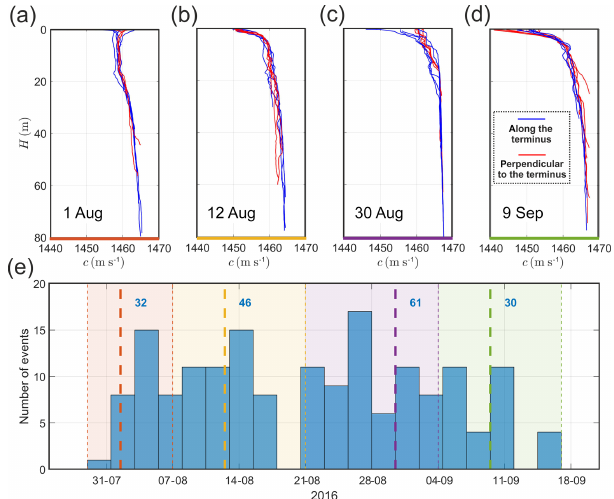
Figure 2. (a–d) Sound velocity profiles for CTD surveys oriented perpendicular (red) and parallel (blue) to the glacier terminus, to- gether with (e) the corresponding frequency of calving occurrence. Locations of the CTD transects taken during the study period are shown in Fig. 1 with the same red and blue colors. Thick, dashed lines mark the dates of the CTD measurements. Blue numbers in the lower panel (e) provide the number of calving events assigned to each set of sound speed profiles.